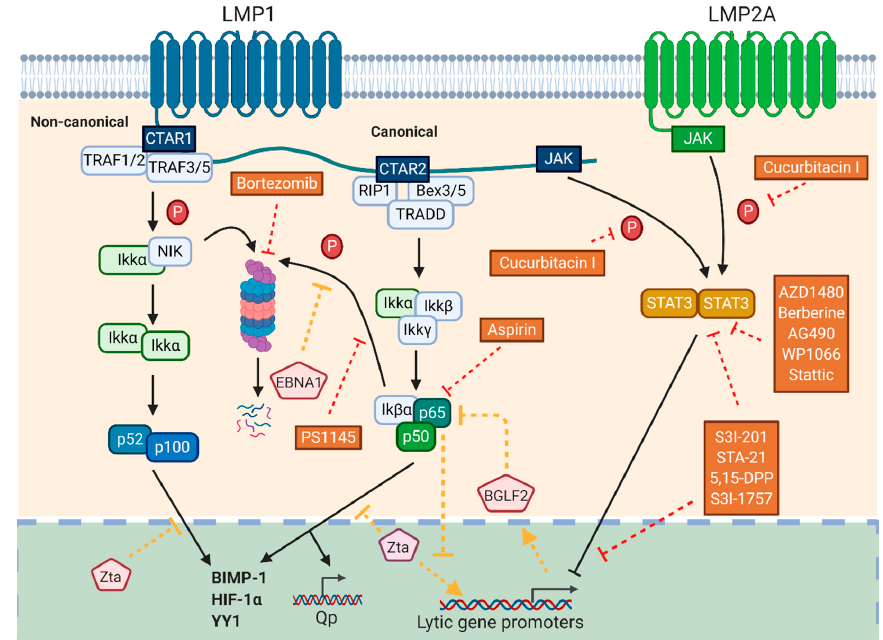
Figure 4. Relationship between EBV proteins, NF- κ B, and STAT3 signaling pathways and the modes of action of compounds with lytic induction potentials. LMP1 could activate both canonical and non-canonical NF- κ B pathways. RelA(p65) could bind and activate Qp-EBNA1 expression, while itself could, in turn, be inhibited by EBNA1 through the prevention of I κ K phosphorylation. RelA(p65) interacts with Zta and abrogates its ability to transactivate other EBV genes, while Zta inhibits the activation of NF- κ B-responsive gene promoters. EBV lytic protein encoded by BGLF2 was shown to interact with RelA(p65), preventing its phosphorylation and nuclear translocation. Bortezomib, PS1145, and aspirin reactivate EBV lytic cycle by preventing the degradation of NF- κ B inhibitor, the phosphorylation of I κβα , and translocation of RelA(p65), respectively. Both LMP1 and LMP2A could phosphorylate STAT and inhibit the activation of lytic cycle of EBV. STAT inhibitors such as cucurbitacin I, AZD1480, and S3I-201 reactivate lytic cycle of EBV by either inhibiting phosphorylation, homodimerization, DNA binding, or transcriptional activities of